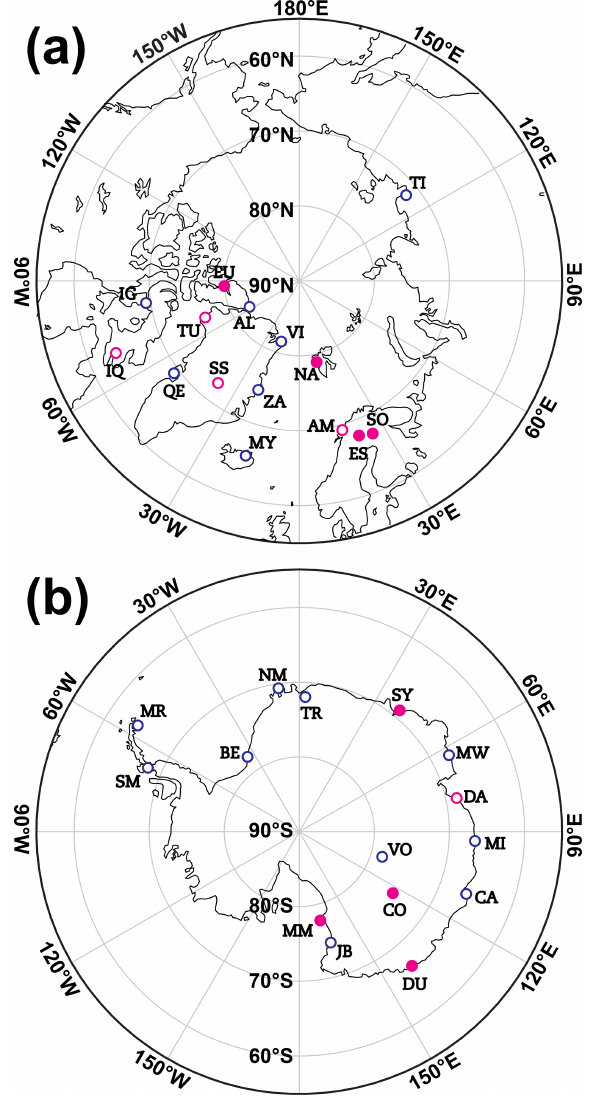
Figure 1. Locations of research stations in (a) the Arctic and (b) the Antarctic and their respective abbreviations as listed in Table 1. Red open circles mark stations with atmospheric lidar measurements, while red filled circles refer to stations with published PSC mea- surements. Other stations of potential interest for ground-based PSC observations are marked by blue open